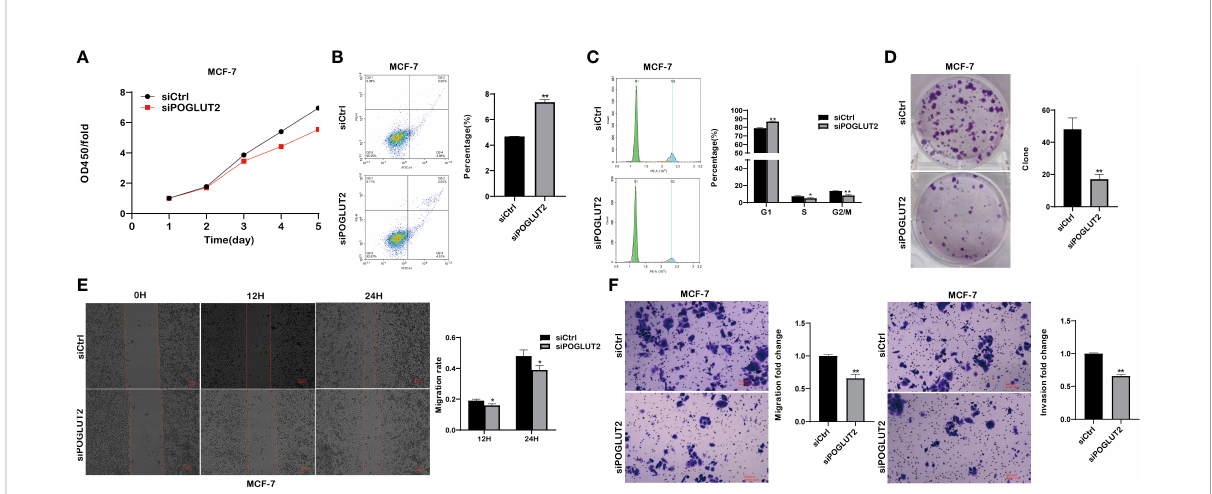
FIGURE 9 POGLUT2 regulates cell proliferation, apoptosis, cell cycle, clone formation, migration, and invasion in breast cancer cell line MCF-7 in vitro . (A) Decreased cell proliferation was found in POGLUT2 knockdown MCF-7 cells. (B) Increased cell apoptosis was found in POGLUT2 knockdown MCF-7 cells. (C) Increased G1 phase and decreased S and G2 phase in POGLUT2 knockdown MCF-7 cells. (D) Decreased cell clone formation in